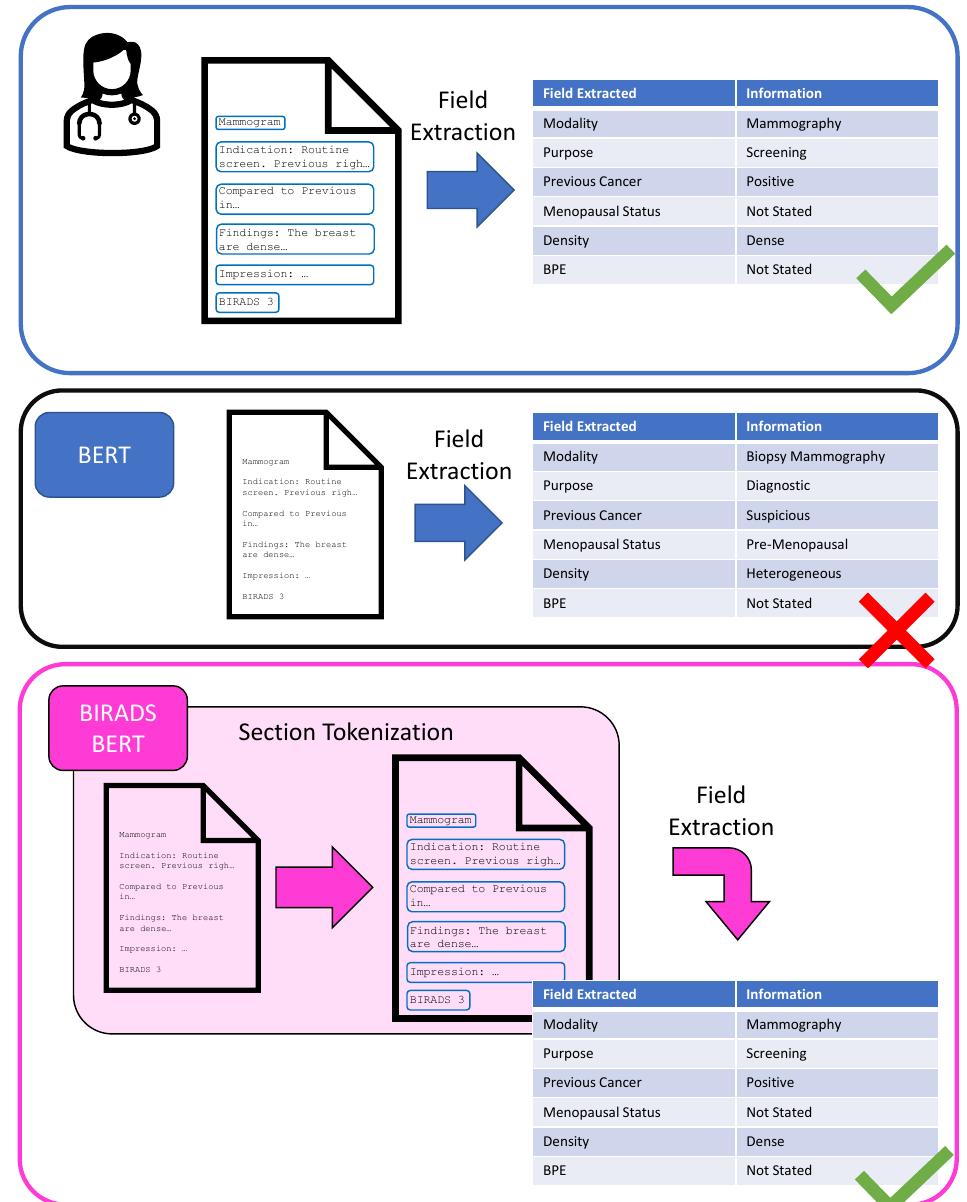
Figure 1. This project aims to improve health indicator field extraction tasks by using section segmentation to narrow down the free-text report length. When a radiologist reads a report, they can divide the report into sections that are useful for finding specific information. With a classic BERT framework, the report is fed into the model without narrowing the report into sections, resulting in some confusion as to where the information is located. Using a BI-RADS BERT model to segment sections before field extraction, we achieve a higher